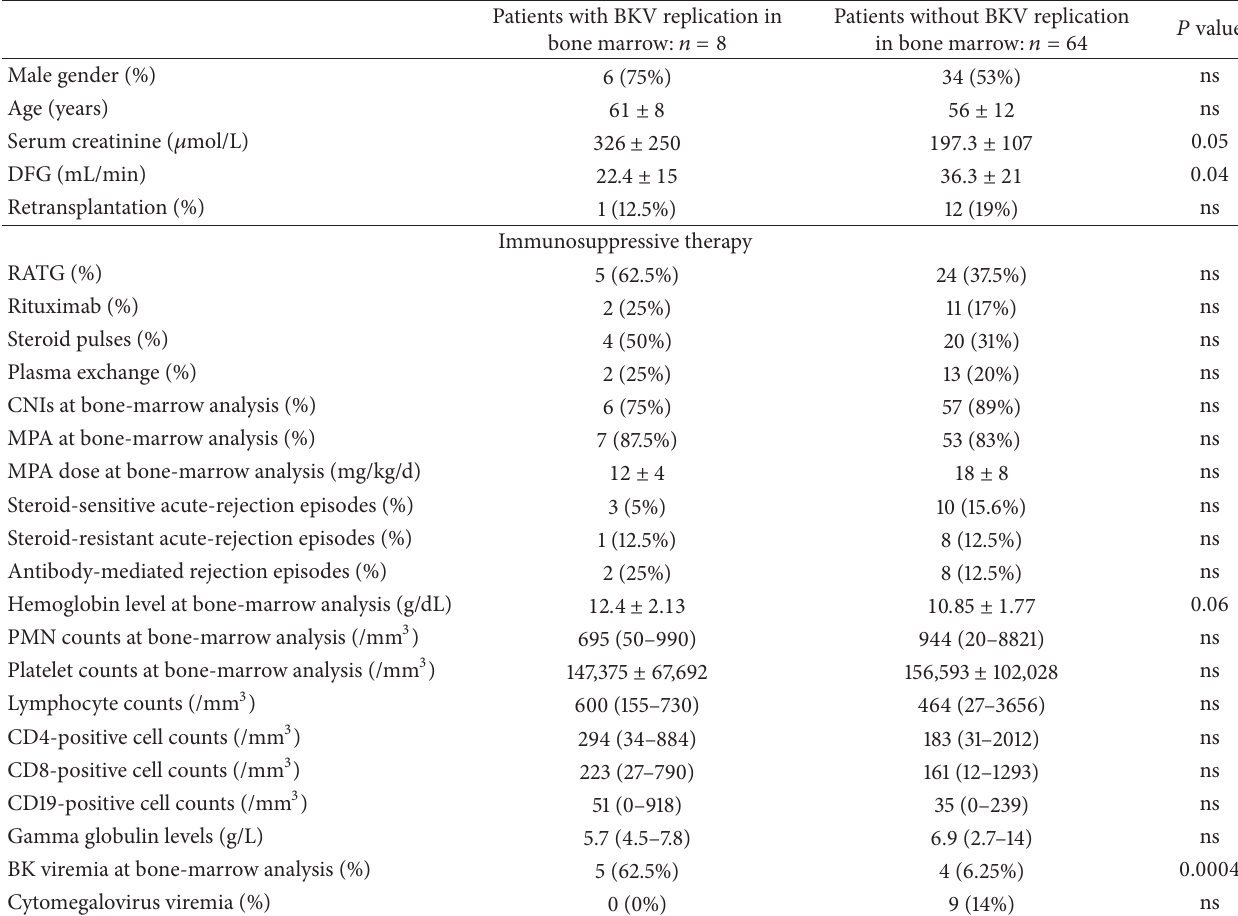
Table 5: Comparisons between patients with and without BKV replication within bone marrow. Patients with BKV replication in Patients without BKV bone marrow: 𝑛 = 8